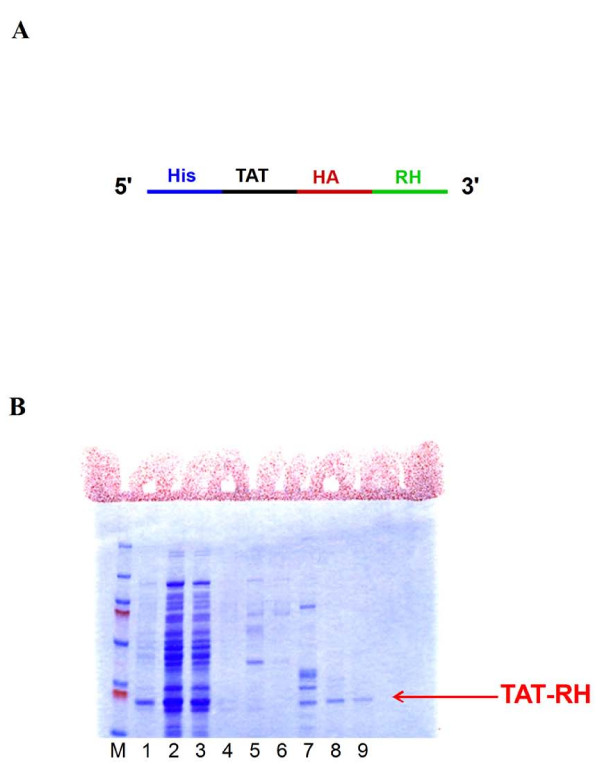
TAT-RH protein design and purification. A) We synthesized and purified a protein reproducing the RH domain of GRK5, TAT-RH. To this aim, RH gene was cloned into the pTAT-HA vector comprising the 11 aminoacid TAT domain, that is the minimum sequence of HIV TAT able to transduce into cells, and histidine and HA as N-terminal tags. B) The purified protein (~24 kDa) was visualized by electrophoretic analysis of samples from all steps of the purification process and gel staining. M = marker; Lane 1 = start; Lanes 2-3 = flow through; Lanes 4-6 = wash; Lanes 7-9 = imidazole.